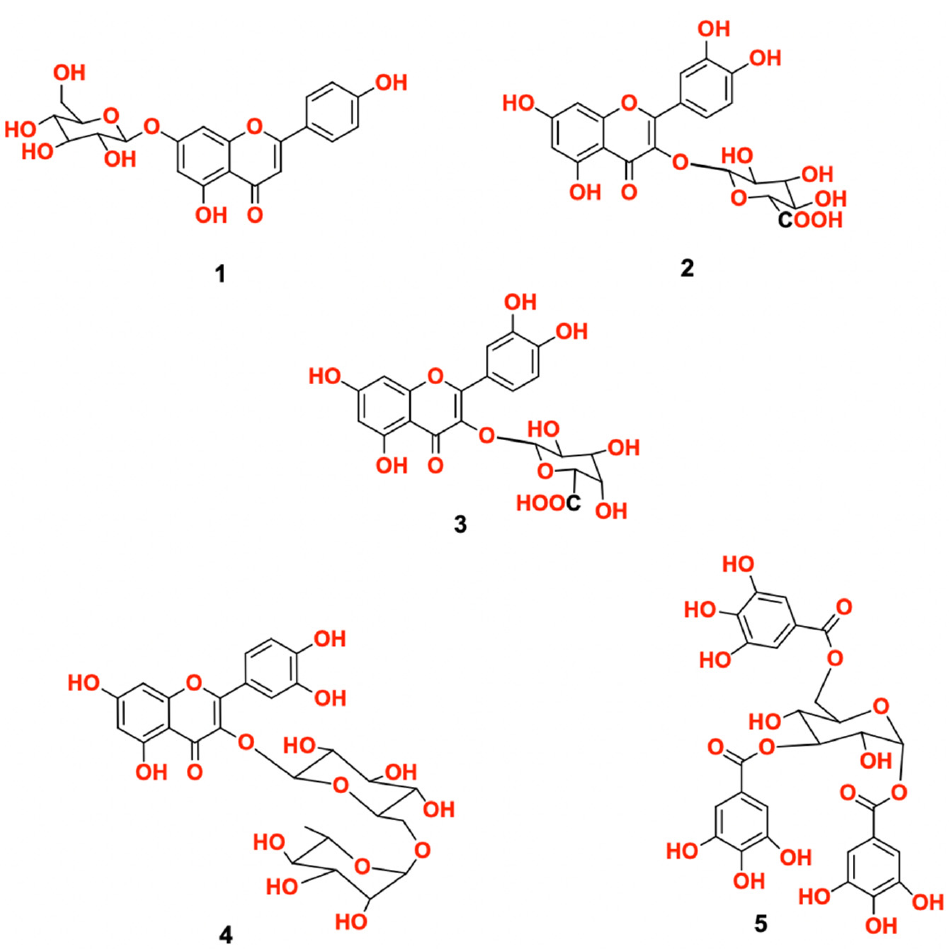
Figure 1. Isolated compounds 1 – 5 from C. oblongifolia .